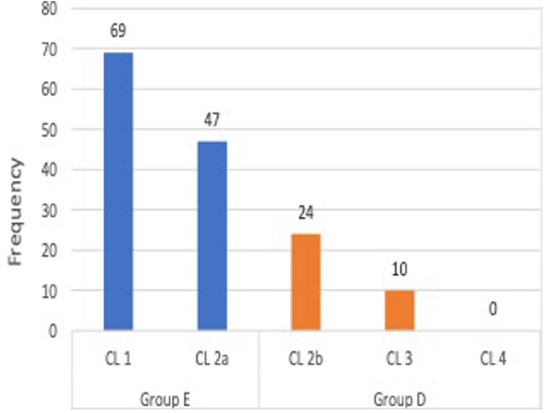
Fig. 5 Cormack-Lehane distribution of